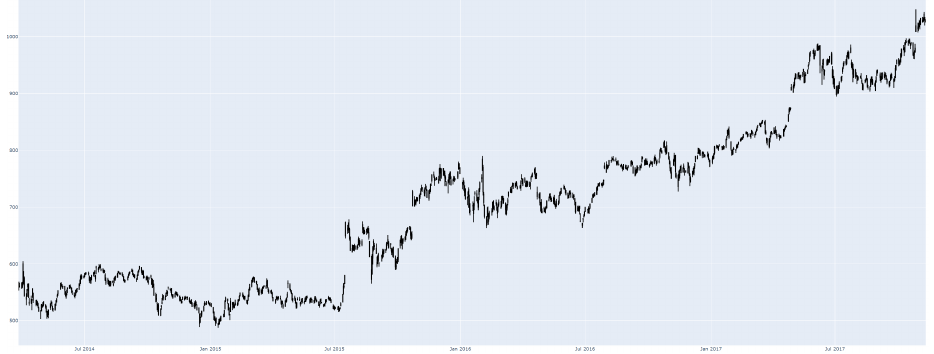
Figure 5. A graph for visualizing the overall value of Total Resource on Google.